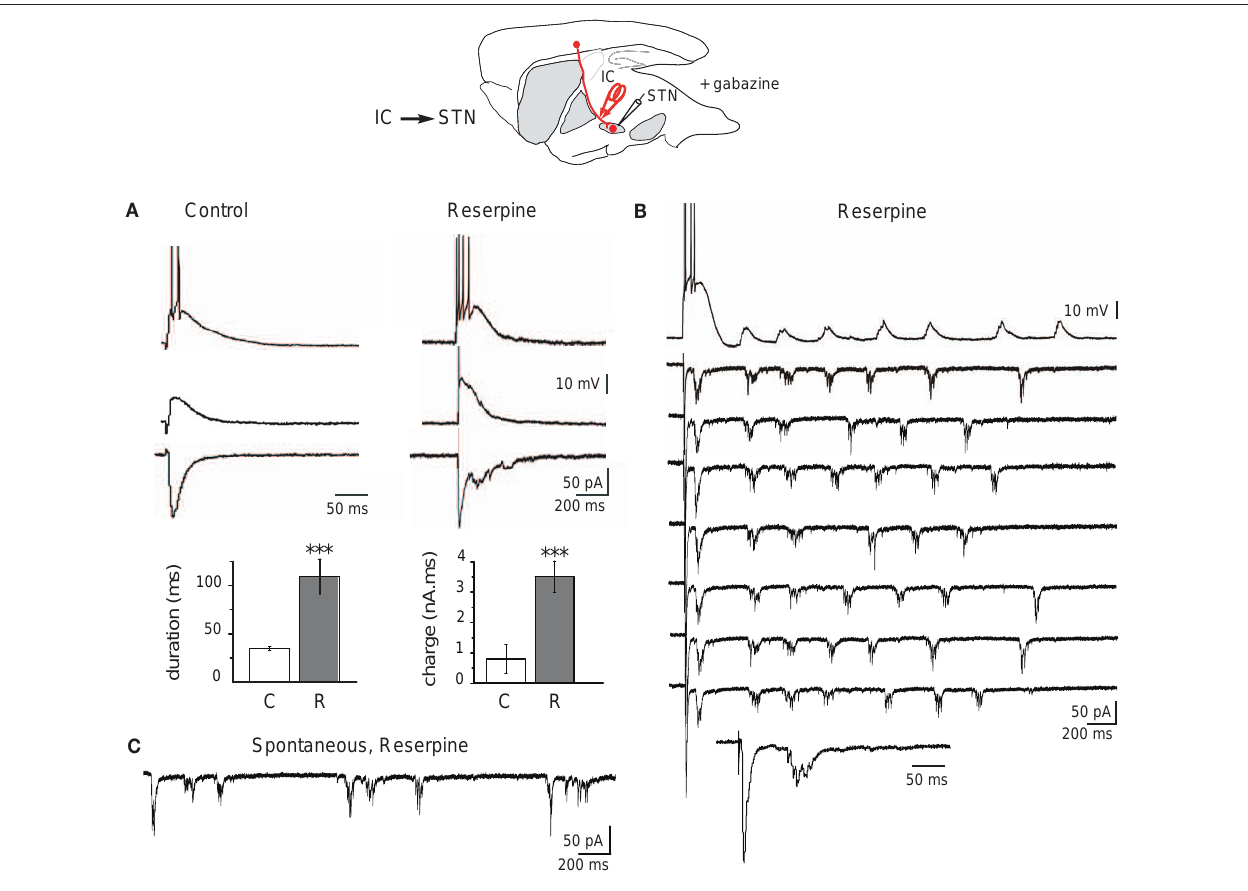
Figure 1 | response of STN neurons to internal capsule stimulation in control and dopamine-depleted BgS in the continuous presence of gabazine (10 μM). Top: schematic illustration of the experimental design with the stimulation (red) and recording sites. (A) Examples of evoked glutamatergic EPSPs (current clamp traces at V = − 60 mV (top) and V = − 70 mV (middle) and m m EPSCs (voltage clamp traces at V = − 70 mV, bottom) recorded from the same H STN neuron in response to a single shock (100 μs, 300 μA) delivered to the internal capsule (IC) in the BGS from control (left) and reserpine-treated (right) mice. Note the difference in time calibration between left and right